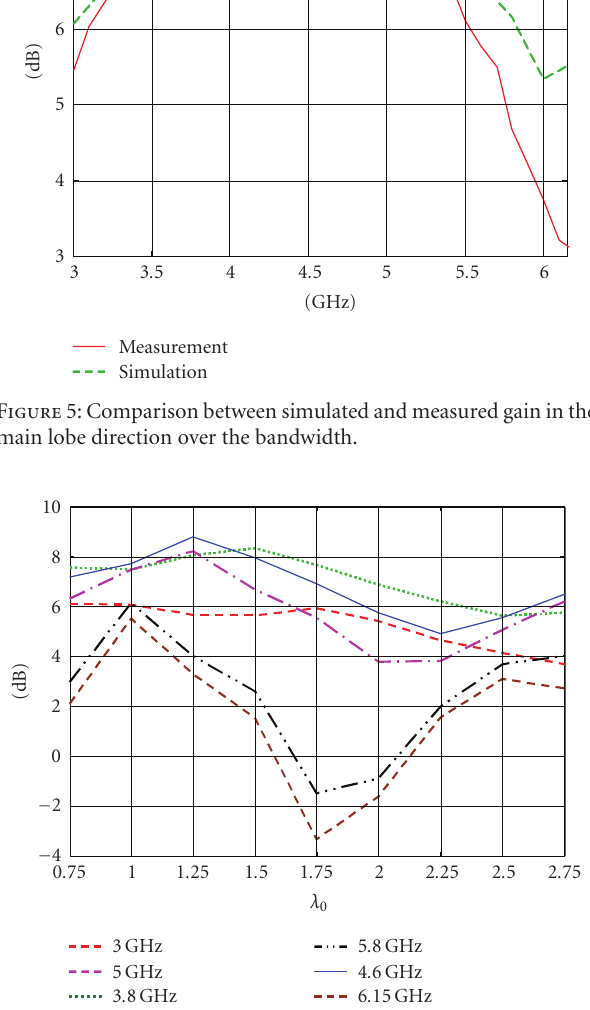
Figure 6: Gain in the main lobe direction as a function of the ground plane size at di ff erent frequencies. ( λ 0 is the wavelength cor- responding to the central frequency of the impedance bandwidth of the antenna).